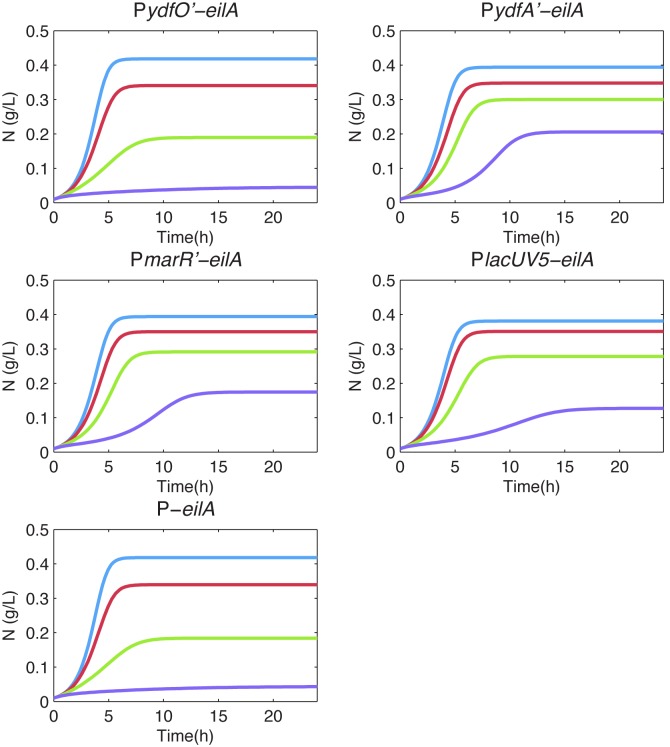
Modeling results comparing controllers at different [C2mim]Cl concentrations.A) pPydfO’-eilA, B) pPydfA’-eilA, C) pPmarR’-eilA, D) pPlacUV5-eilA, and E) pP-eilA. Blue: 0 mM [C2mim]Cl, red: 100 mM [C2mim]Cl, green: 200 mM [C2mim]Cl, purple: 400 mM [C2mim]Cl.